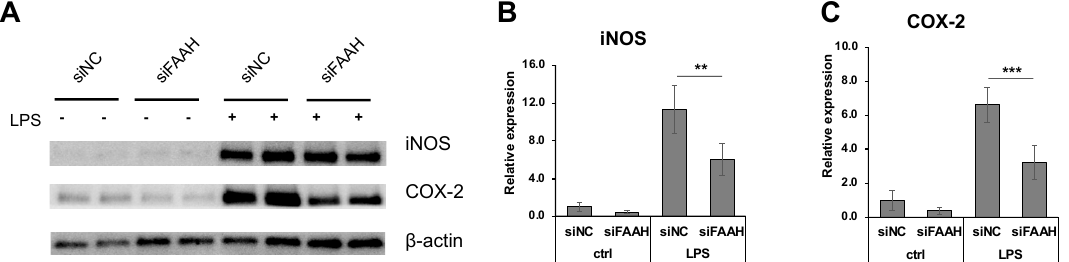
Figure 8. Expression of iNOS and COX-2 in FAAH knockdown cells. BV2 cells after 24 h siRNA transfection were treated with LPS for 18 h, and the cell lysates were collected. Western blotting was performed for iNOS, COX-2, and β -actin ( A ). Relative expression levels to β -actin are shown for iNOS in ( B ) and for COX-2 in ( C ). The + and – symbols indicate the presence or absence, respectively, of LPS. Data are presented as means ± S.D. (n = 5) determined by two-way ANOVA. **, and *** denote p < 0.01 and p < 0.001, respectively.